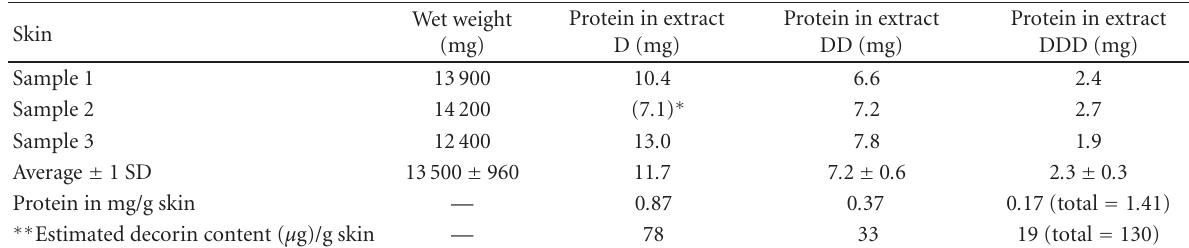
Table 1. Recovery of proteins in extracts from three separate pieces of the same skin treated in identical manner.